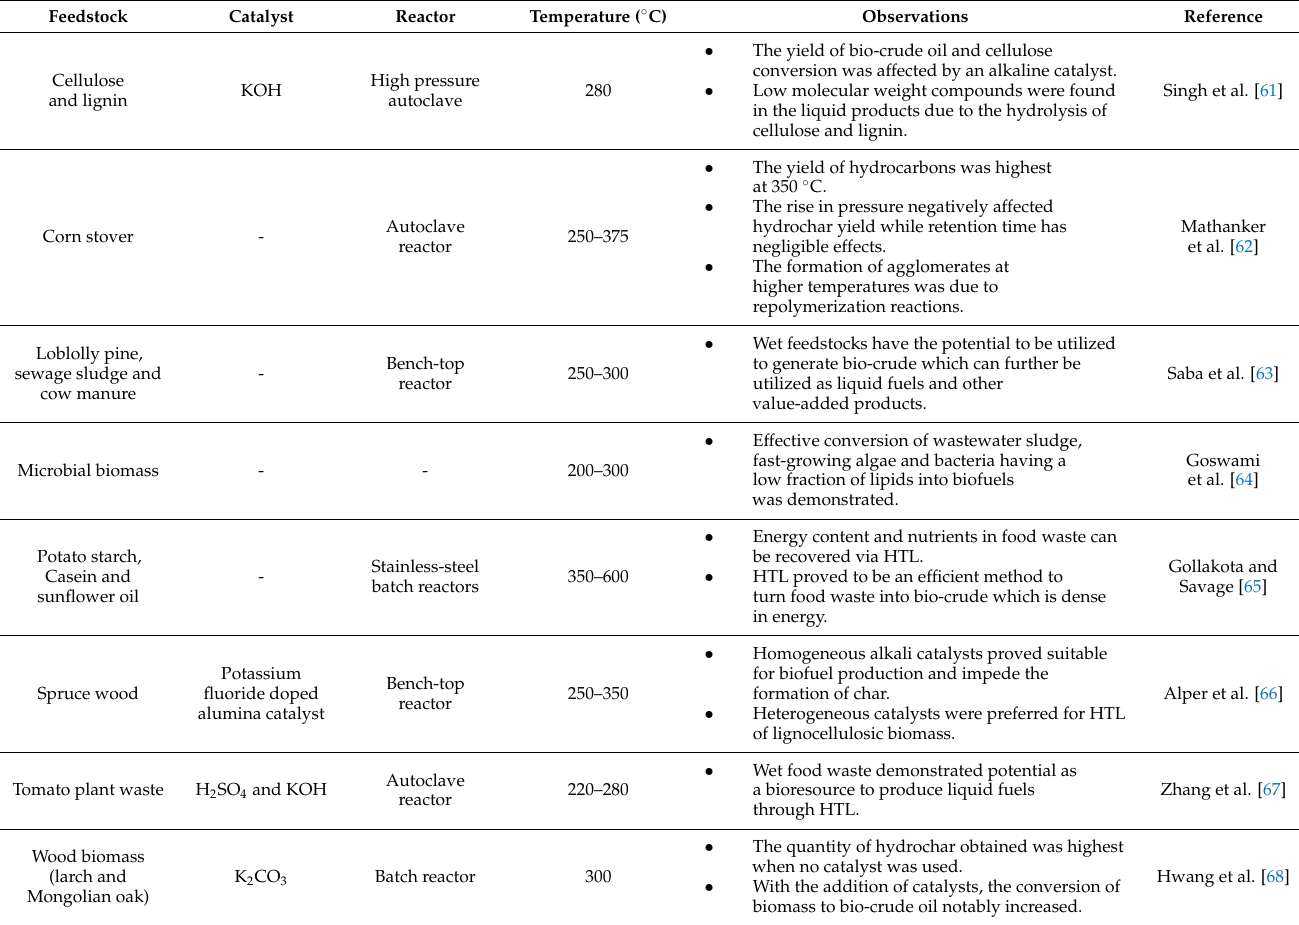
Table 4. Summary of notable works on liquefaction of waste